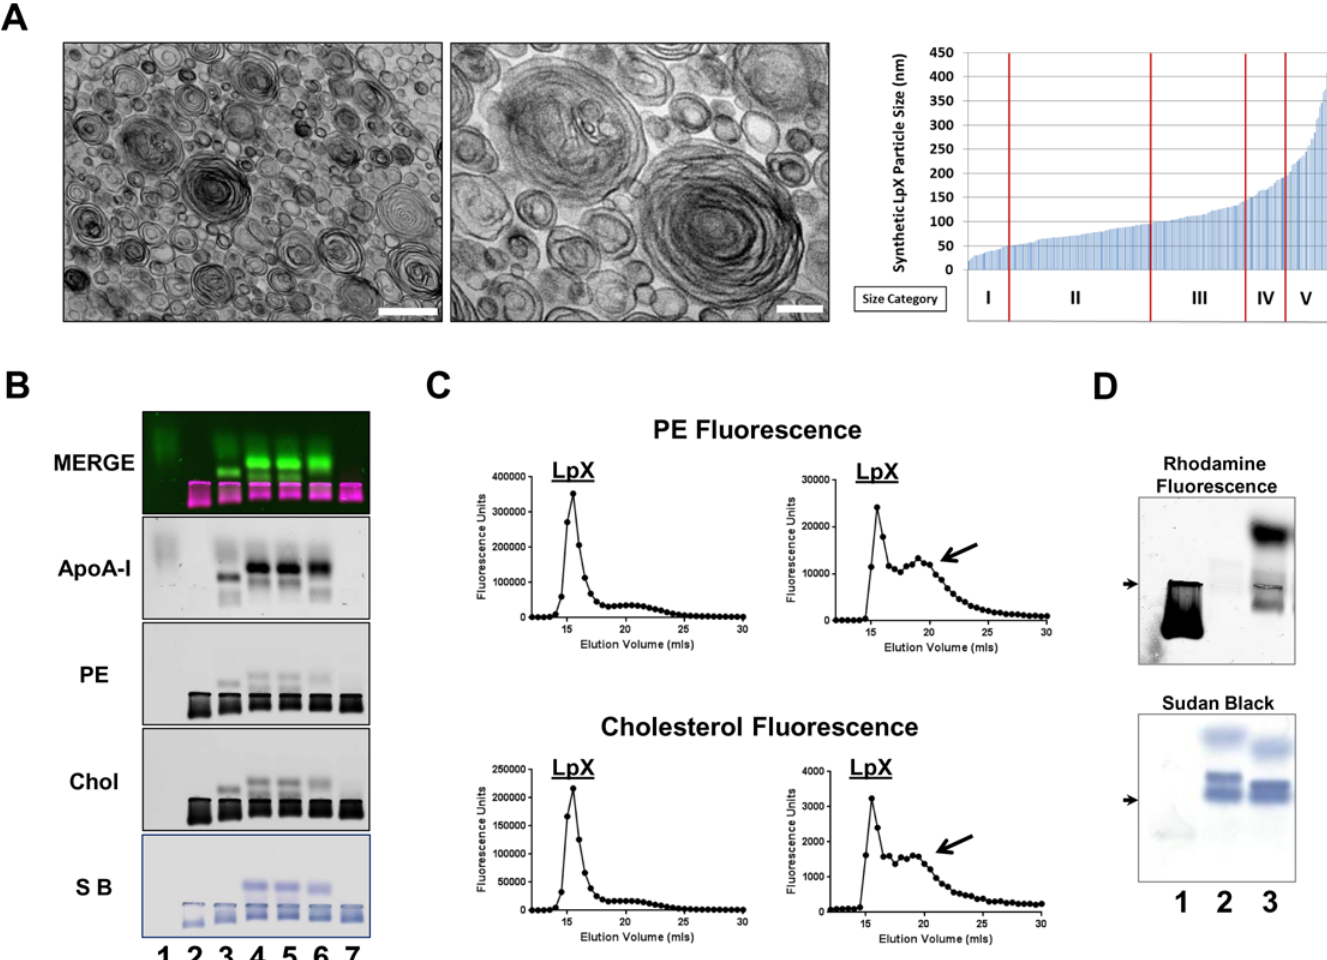
Fig 1. LpX remodeling in vitro . (A) TEM analysis of synthetic LpX particles. Left panel : Low magnification image (Scale bar; 500 nm ) . Middle panel : High magnification (Scale bar; 100 nm). Right panel : LpX particle size distribution. Size categories (nm): I (0 – 50), II (50 – 100), III (100 – 150), IV (150 – 200), and V (200 – 245). Small unilamellar vesicles as well as small, medium and, large multivesicular vesicles are seen. (B) LpX remodeling by LCAT and apoA-I in vitro. Agarose gel electrophoresis of LpX labeled with both fluorescent PE (red) and cholesterol ( blue ) incubated with Alexa 647-tagged apoA-I ( green ) and/or LCAT in vitro and scanned. Colocalization of LpX PE and cholesterol fluorescence is seen as magenta (merged image). Lane 1: ApoA-I; Lane 2: LpX; Lane 3: LpX + ApoA-I; Lanes 4 – 6: LpX + ApoA-I + 2, 4, or, 6 mg LCAT, respectively; Lane 7: LpX + 6 mg LCAT. (C) FPLC analysis of dual fluorescent PE- and cholesterol-tagged LpX incubated without ( left ) or with apoA-I and 6 mg LCAT (right ). Fractions were analyzed for rhodamine (PE) fluorescence ( upper panels ) and TopFluor cholesterol fluorescence ( lower panels ). Note the additional peak ( arrows ) after incubation with apoA-I and LCAT. (D) LpX is converted to plasma HDL in vitro. Fluorescent PE-tagged LpX was incubated overnight with pooled human plasma. Agarose gels were scanned for PE fluorescence and then stained with Sudan Black. Lane 1: Fluorescent LpX. Lane 2: Pooled human plasma. Lane 3: Pooled human plasma + fluorescent LpX. Arrows indicate